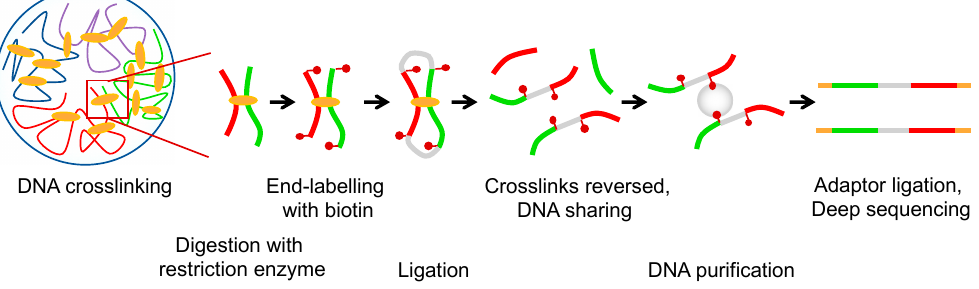
Figure 1. Whole-genome chromatin conformation capture (Hi-C) detect chromosomal rearrangements. Overview of the Hi-C method. Briefly, cells are first treated with formaldehyde, which crosslinks chromatin segments that are spatially adjacent. The crosslinked chromatin is thereafter digested with restriction enzyme(s). The resulting DNA fragments are labelled with biotinylated nucleotides and subjected to ligation. Crosslinks are reversed, DNA sheared, and biotinylated fragments are isolated using streptavidin beads. Finally, deep sequencing of the purified fragments identifies which chromosomal regions were in proximity at the time of formaldehyde cross-linking. Recently, the resolution of Hi-C has been improved by replacing restriction enzyme cleavage with micrococcal nuclease (MNase) digestion [23], or using in situ Hi-C, in which DNA-DNA proximity ligation is performed in intact nuclei [24].